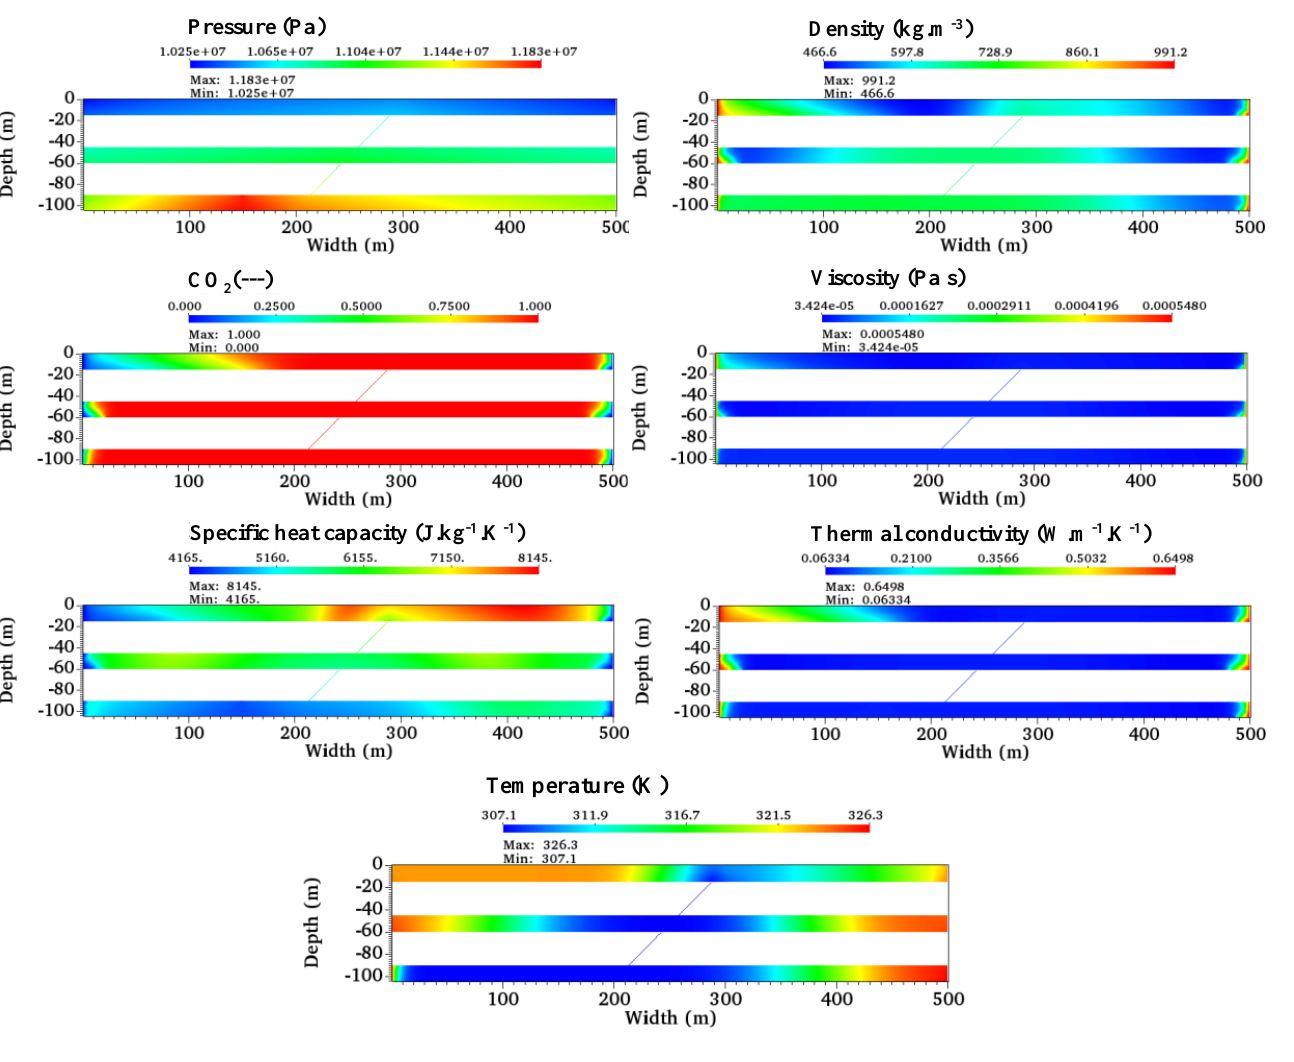
Figure 17. Distribution of pressure, density, CO 2 , viscosity, specific heat capacity, thermal conductivity, and temperature after 300 days of injection for the case with thermal gradient = 0.03, injection rate = 0.41319 m 3 /s, 𝛼 𝑙 = 5 and 𝛼 𝑡 = 0.5 and fracture aperture = 300 µm.